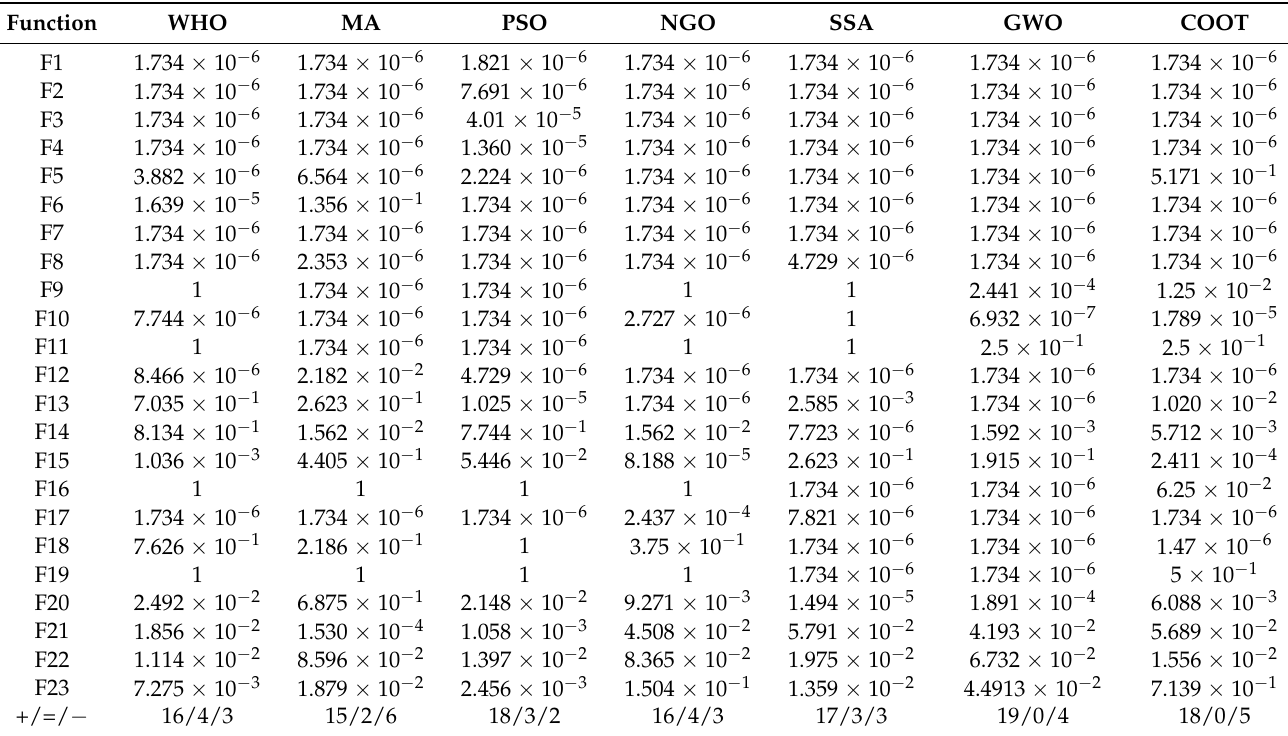
Table 6. The result of Wilcoxon rank sum